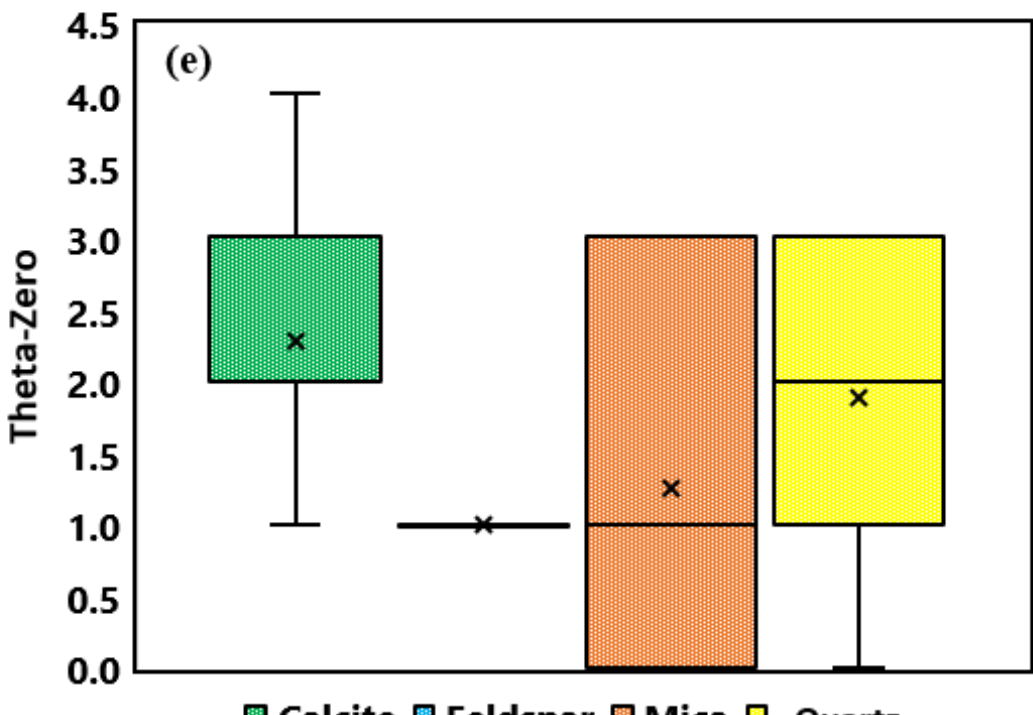
Figure 3. Boxplots of inputs. ( a ) Pressure, ( b ) Temperature, ( c ) Salinity, ( d ) Contact angle type and ( e ) Theta. Zero.